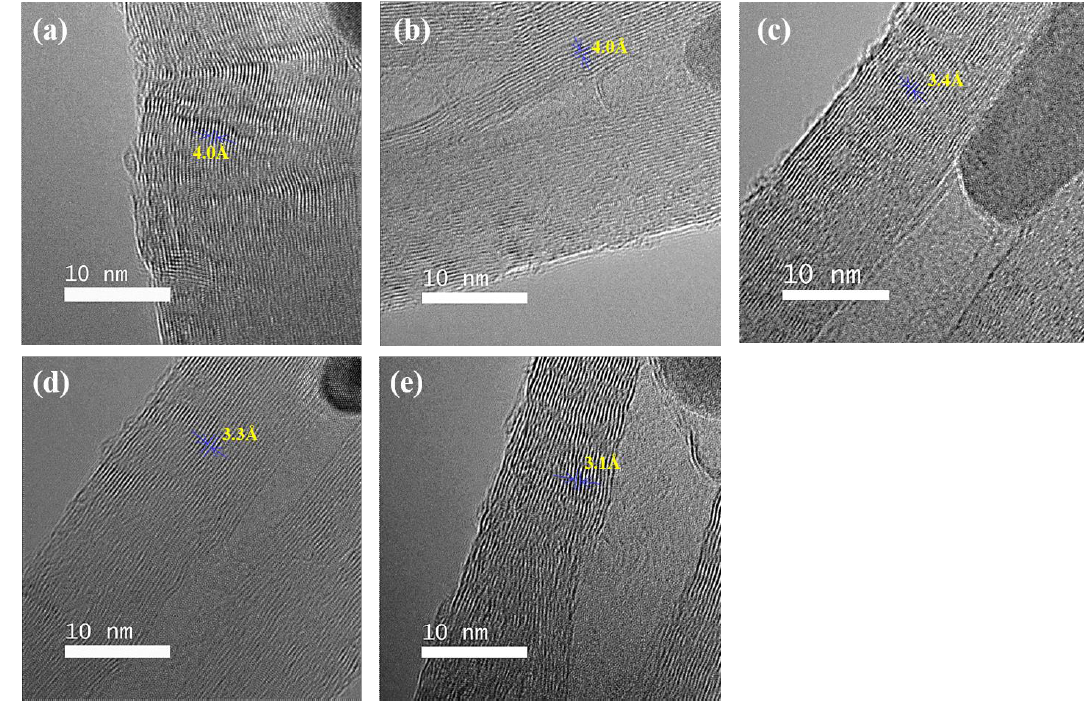
Figure 7. TEM images of the synthesized CNT forests with various R values: ( a ) R = 0, ( b ) R = 0.17, ( c ) R = 0.3, ( d ) R = 0.5, and ( e ) R = 0.67.